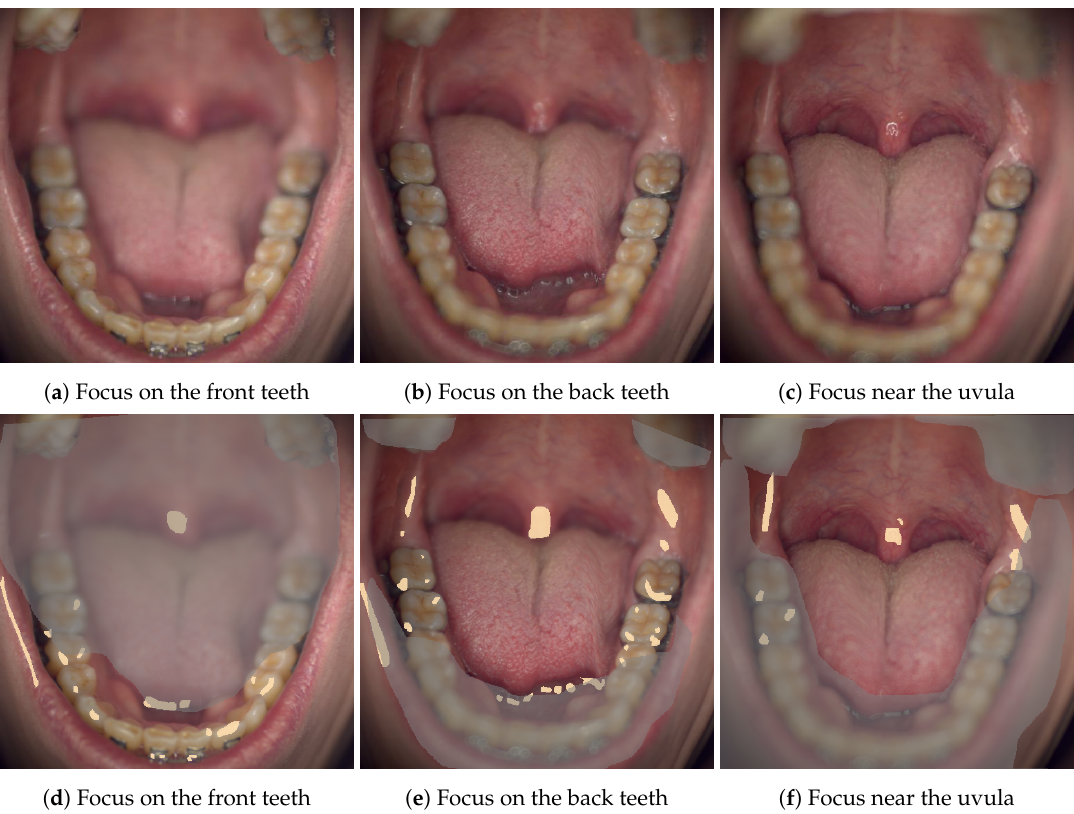
Figure 6. ( a – c ) On close range, short depth of field in Specim IQ spectral camera necessitates multiple shots of the same scene on different focal points. ( d – f ) The out of focus areas are labeled with the appropriately named gray out of focus area label. The off-white markings label specular reflections .